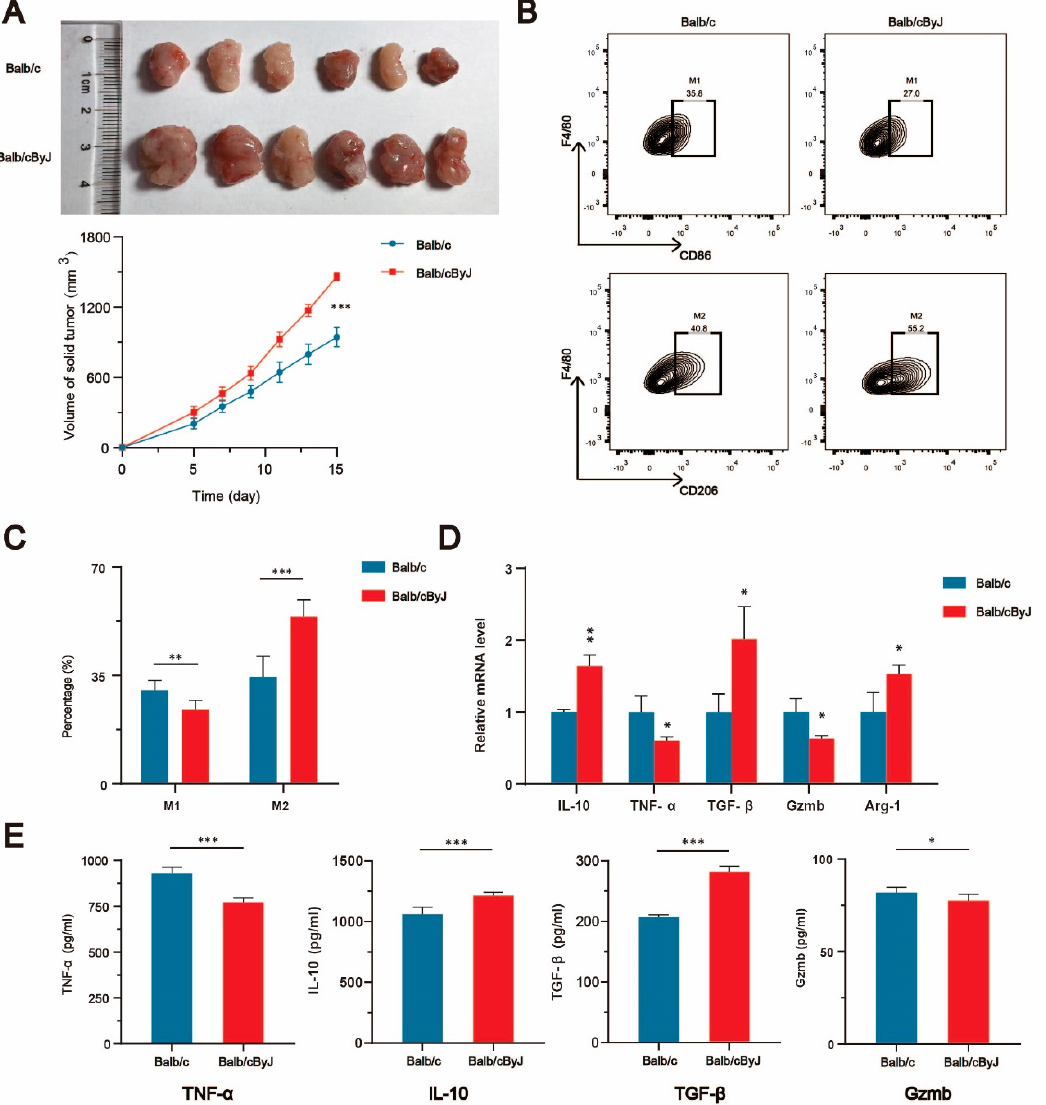
Figure 5. The deletion of ACADS promotes tumor growth and induces TAM polarization to M2 macrophages . ( A ). Mouse subcutaneous tumor model in Balb/c and Balb/cByJ mice. ( B , C ). Flow cytometry analysis of TAMs. ( D ). The expression of factors related with TAMs in tumor tissues was detected by qPCR. ( E ). The expression of factors related with TAMs in tumor tissues was detected by ELISA. (“ * ” represents p<0.05 , “ ** ” represents p<0.01 , “ *** ” represents p<0.001 )